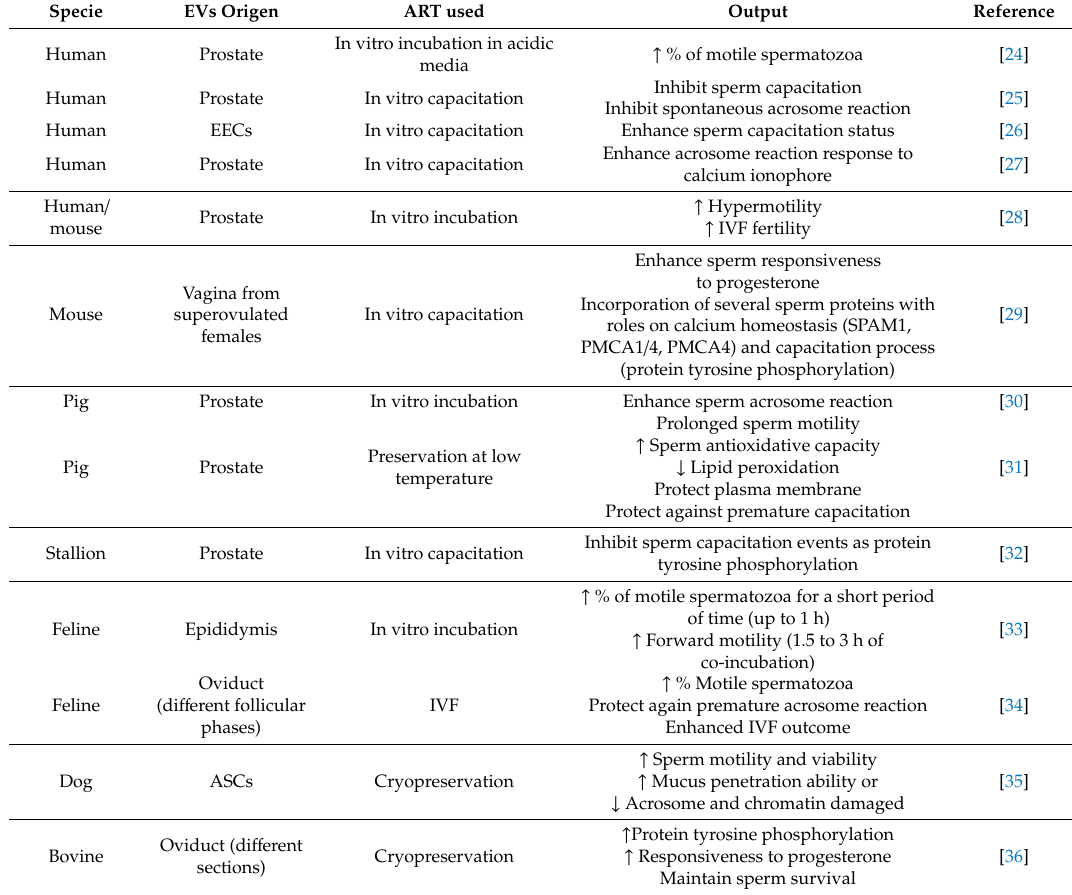
Table 2. E ff ects of co-incubation of extracellular vesicles and spermatozoa on ART